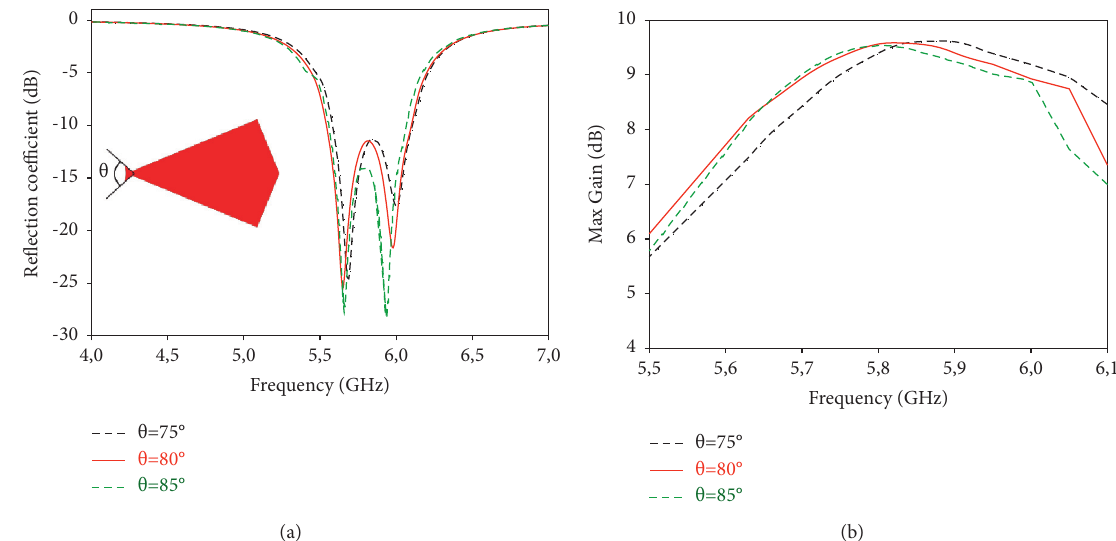
Figure 7: Reflection coefficient (a) and gain (b) for different angle values ( θ ).